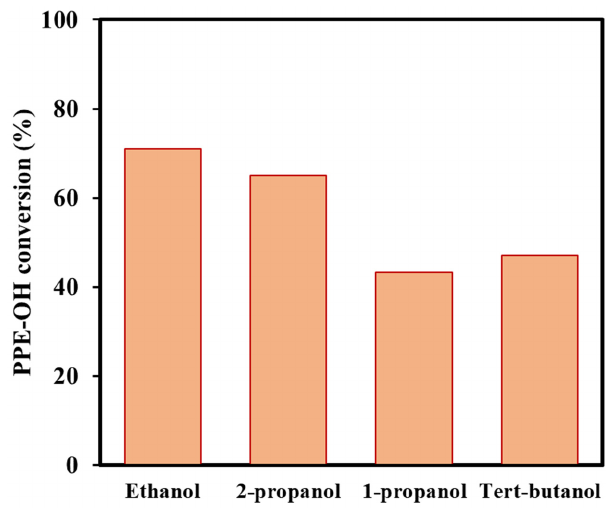
Figure 4. The conversion of 2-phenoxy-1-phenyl ethanol over Ru/C-KOH-2 catalyst at different temperatures. Reaction conditions: 1 h, N 2 atmosphere, 1 wt.% reactant/ethanol, 20 wt.% catalyst loading. Figure 5. The conversion of 2-phenoxy-1-phenyl ethanol over Ru/C-KOH-2 catalyst with different solvents. Reaction conditions: 220 ◦ C, 1 h, N 2 atmosphere, 1 wt.% reactant/solvent, 20 wt.% catalyst